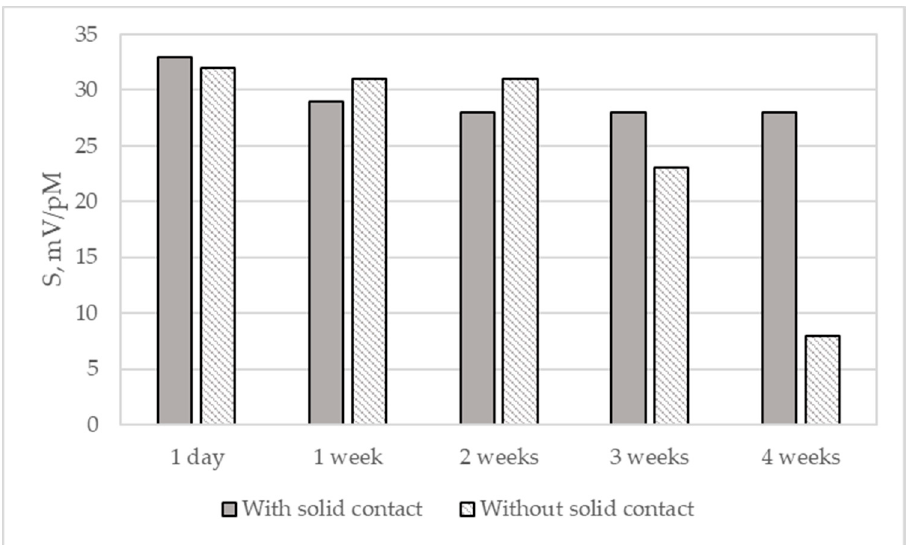
Figure 7. Slopes of the electrode function of the LignoBoost ® kraft based sensors with and without solid contact in Cu(II) solutions during four weeks.